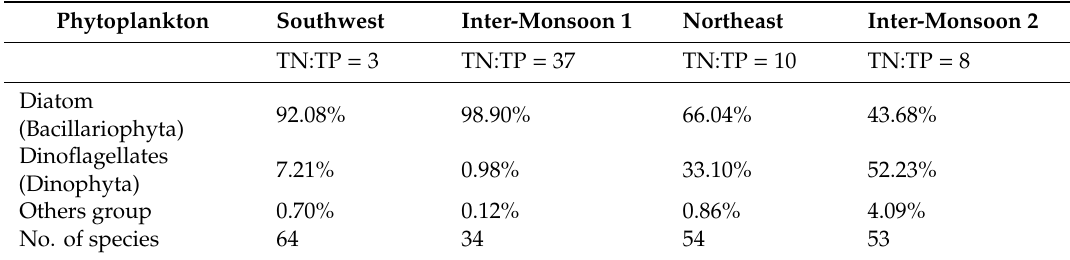
Table 2. Percentages and nutrient ratios (TN:TP) based on Redfield ratio 16:1 contrasting phytoplankton communities between monsoonal seasons in the Sangga Kechil estuarine-mangrove area.